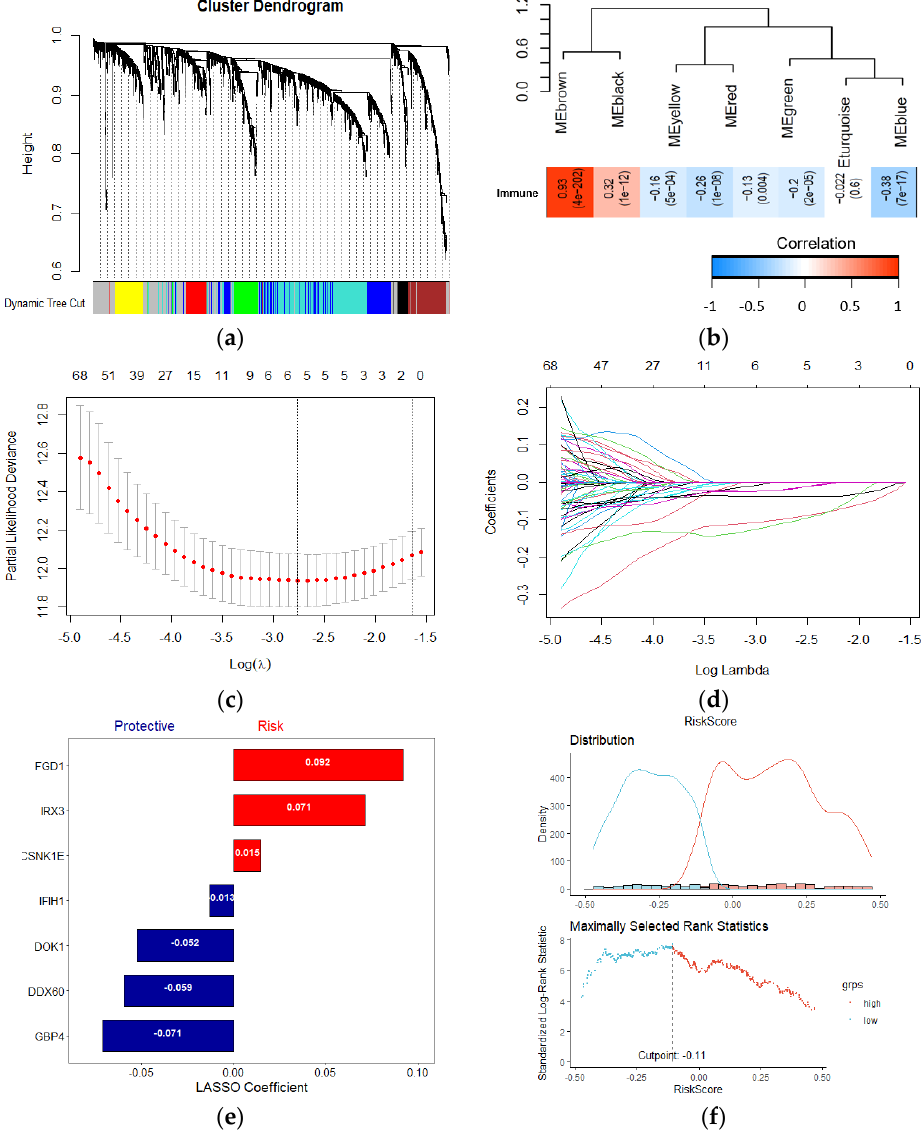
Figure 3. Establishment of a Wnt-immune-related gene signature. ( a ) WGCNA was performed with WNT beta catenin activation-related genes and immune scores; ( b ) A total of 7 non-grey modules were identified. The brown module, which shows the highest correlation (r = 0.93, p = 4e − 202), was considered the most correlated with hypoxia; ( c , d ) The LASSO Cox regression model was used to identify the most robust markers, with an optimal λ value of 0.0515; ( e ) Distribution of LASSO coefficients of the WNT-Immune-related gene signature; ( f ) Scatter plot shows the standardized log-rank statistic value for each corresponding risk score